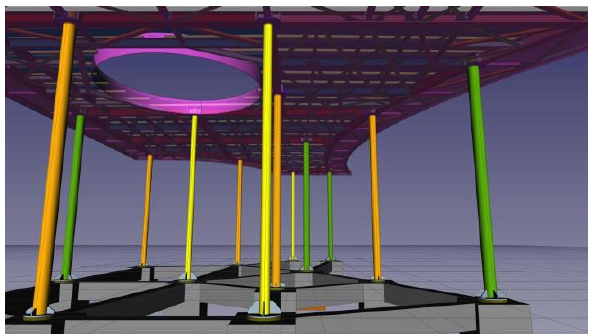
Figure 3. The Freecad BIM Model, a bottom view